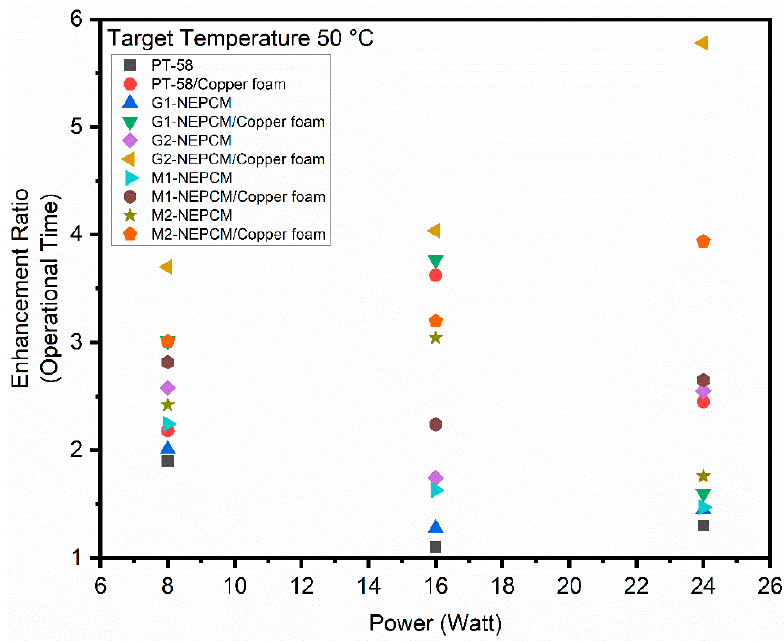
Figure 22. Enhancement ratios comparison for various heat sink configurations at operational time of 50 ℃.